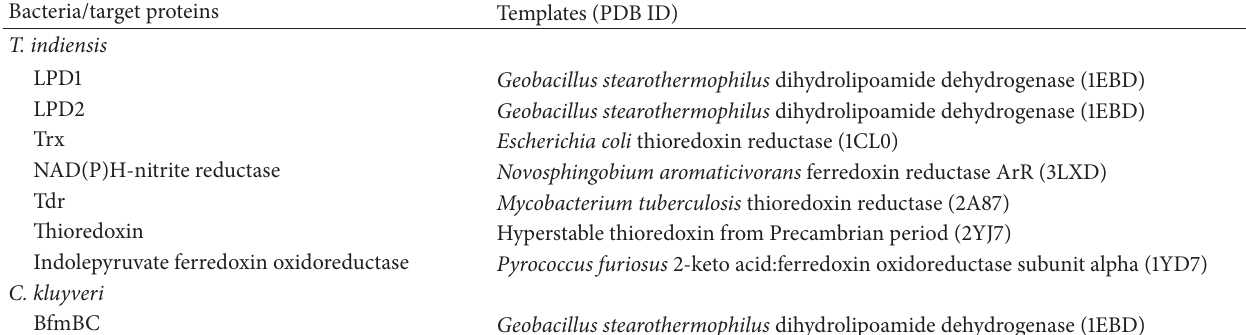
Figure 2: Zymogram analysis of Q Sepharose fractions. Protein samples were resolved by 10% nondenaturing PAGE and visualized by Fe(III) reductase staining. (a) Gel filtration sample 7 was passed through a Q Sepharose column. Four micrograms of proteins from gel filtration fraction 7 (L) and eight micrograms of proteins each from Q Sepharose fractions 6–9 were electrophoresed. (b) Gel filtration fraction 9 was passed through a Q Sepharose column. Eight micrograms of proteins from gel filtration fraction 9 (L) and 15 𝜇 g proteins each from Q Sepharose fractions 1–7 were electrophoresed. (c) Gel filtration fraction 12 was passed through a Q Sepharose column. Four micrograms of proteins from gel filtration fraction 12 (L) and 15 𝜇 g proteins each from Q Sepharose fractions 2–9 were electrophoresed. Table 3: PDB templates used by ESyPred3D program for three-dimensional structure prediction of proteins. Bacteria/target